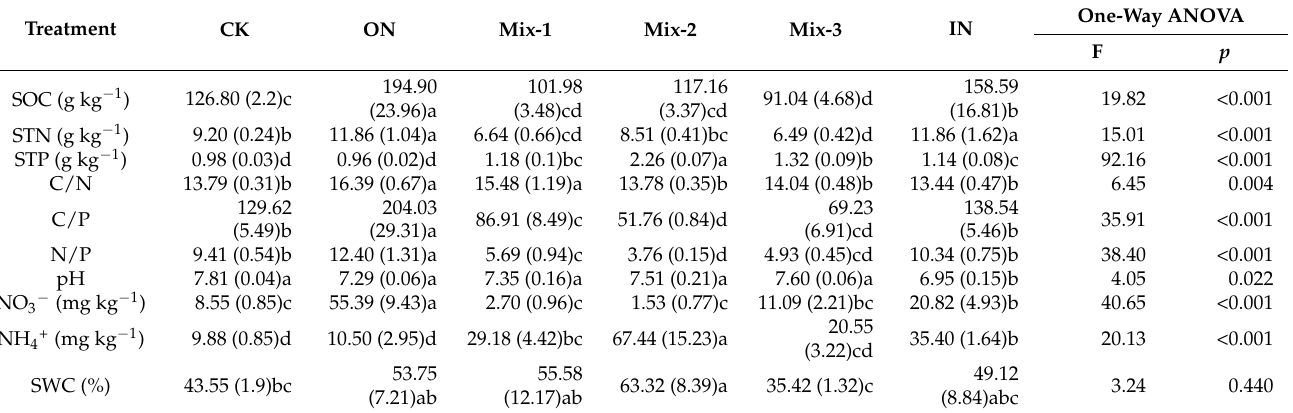
Table 1. Soil properties in different treatments. Abbreviations: NO 3 − , nitrate nitrogen; NH 4+ , ammonium nitrogen; STN, total nitrogen; SOC, soil organic carbon; STP, total phosphorus; SWC, soil water content. Mean ± standard error, n = 3. Different lowercase letters indicate significant differences between treatments ( p <